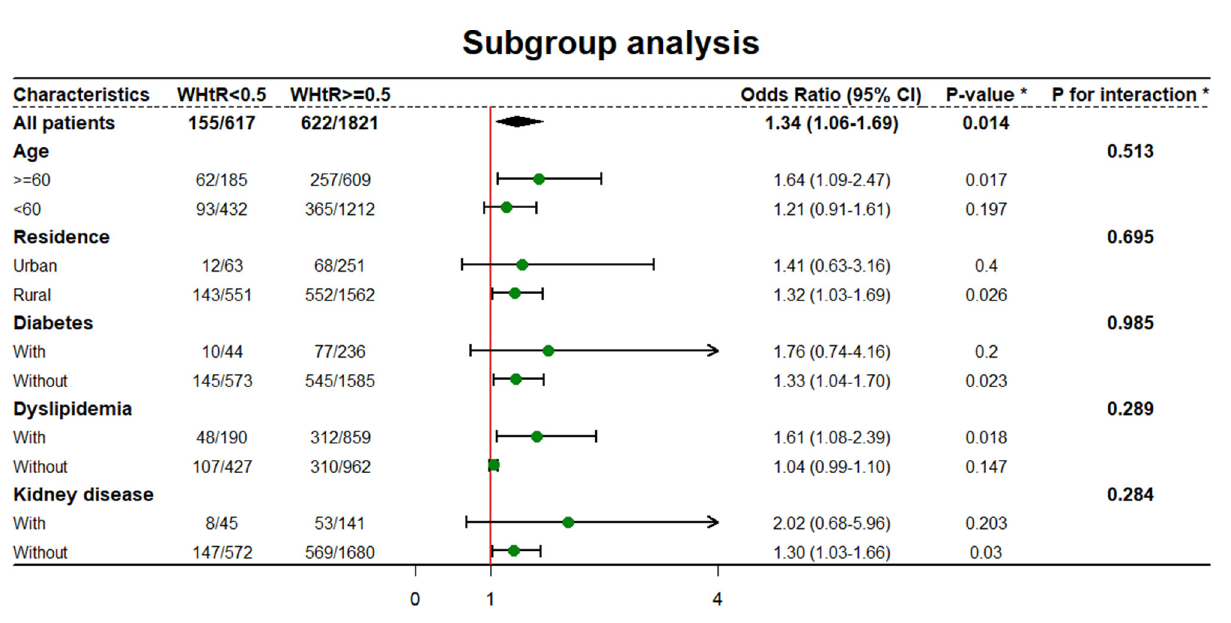
FIGURE3 Subgroup analysis of relationship between WHtR and new-onset hypertension. *WHtR as categorical. *All model was adjusted by age, SBP, DBP, residence, education level, marital status, diabetes, dyslipidemia, kidney disease, cancer, chronic lung disease, liver disease, heart problem, stroke, digestive disease, nervous problems, memory related disease, arthritis, asthma, smoking and drinking unless the variable was used as a subgroup